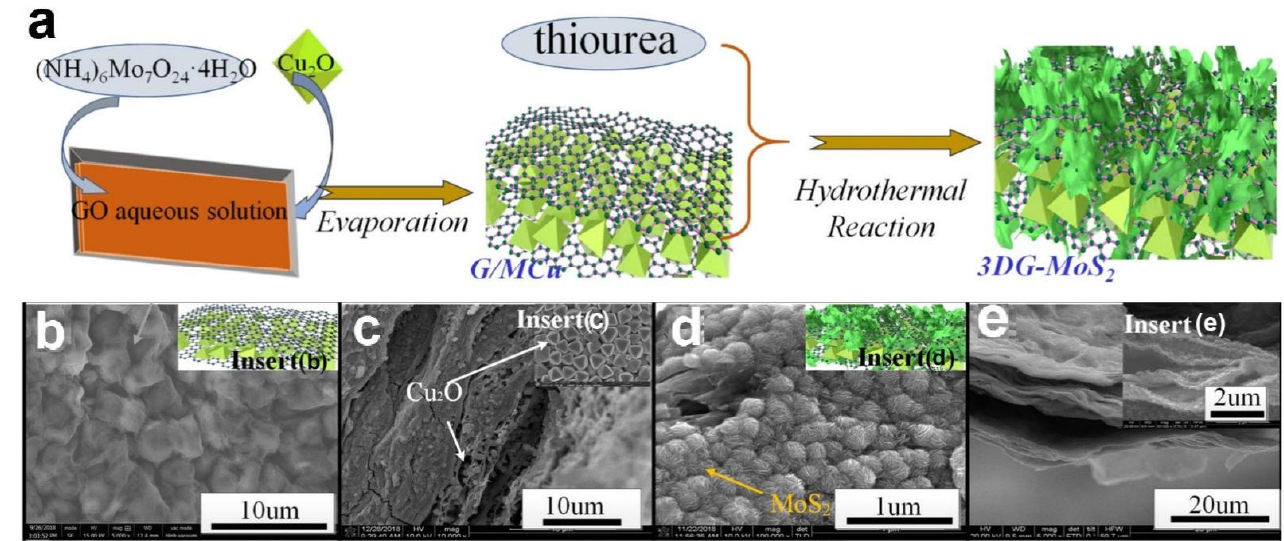
Figure 22. ( a ) Schematic illustration of the fabrication processes of 3DG-MoS2; ( b ) FE-SEM images of section of G/MCu and schematic structure of G/MCu (insert of ( b )); ( c ) Cross-section FE-SEM images of G/MCu and further amplification of c (Insert of ( c )); ( d ) FE-SEM images of 3DG-MoS 2 surface and schematic structure of 3DG-MoS 2 (Insert ( d )); ( e ) Cross-section FE-SEM images of 3DG-MoS 2 with different magnifications. Reproduced with permission [30]. Copyright 2020, John Wiley and Sons.